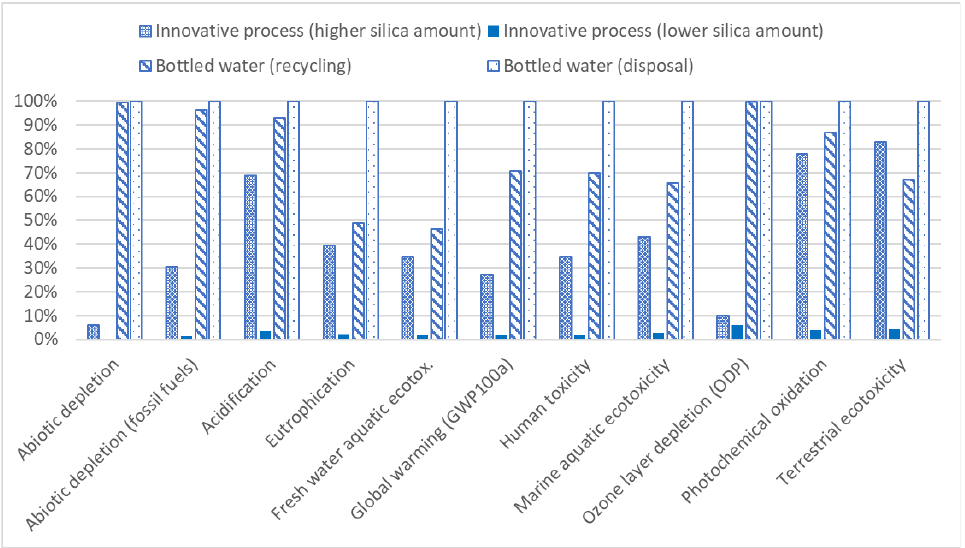
Figure 5. Potential environmental impact comparison among different water treatments: innovative process with higher amount of silica (27 kg/26 m 3 of water) and lower amount of active silica (1.3 kg/26 m 3 of water), use of bottled water with bottle recycling, and bottle disposal.